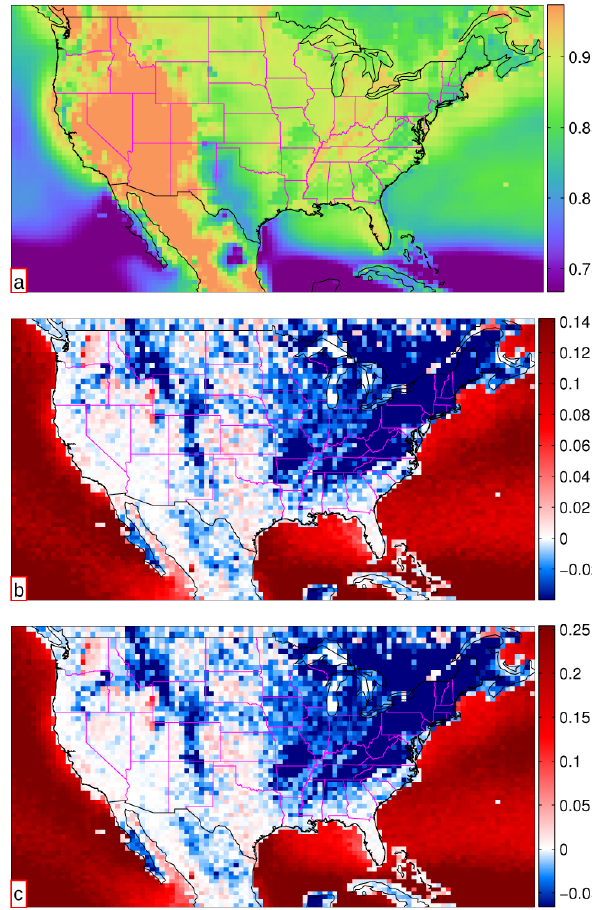
Fig. 13. Variation of the coefficient of variation of WPD at different heights. (a) shows the RCoV of WPD at 80m and (b) and (c) show the difference RCoV of WPD at 100m and 120m from that at